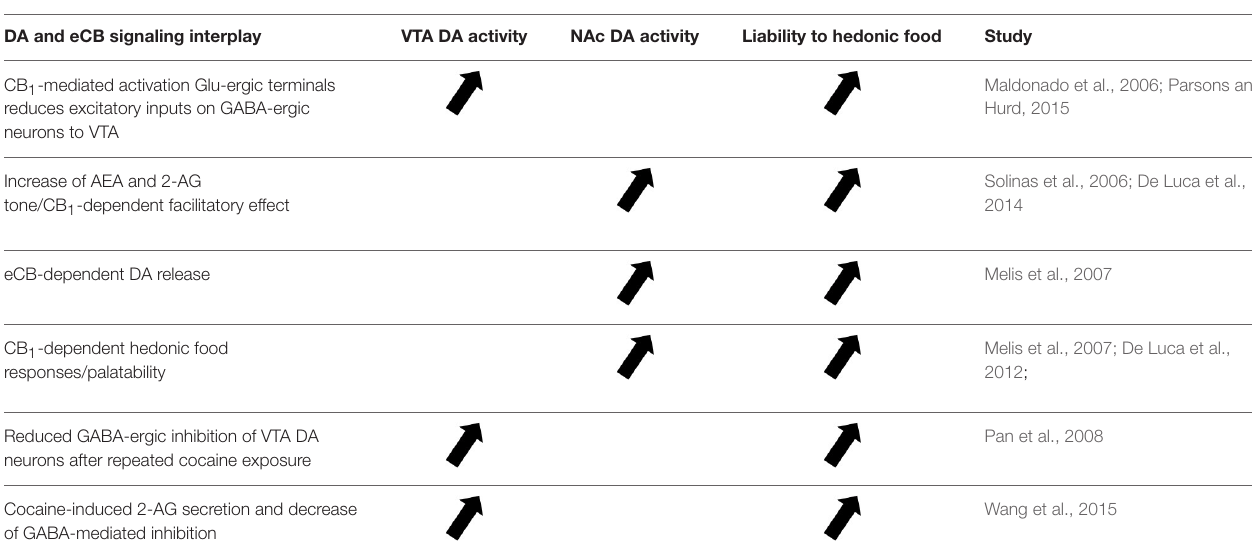
TABLE 1 | Selected studies that investigated the interplay between DA and eCB